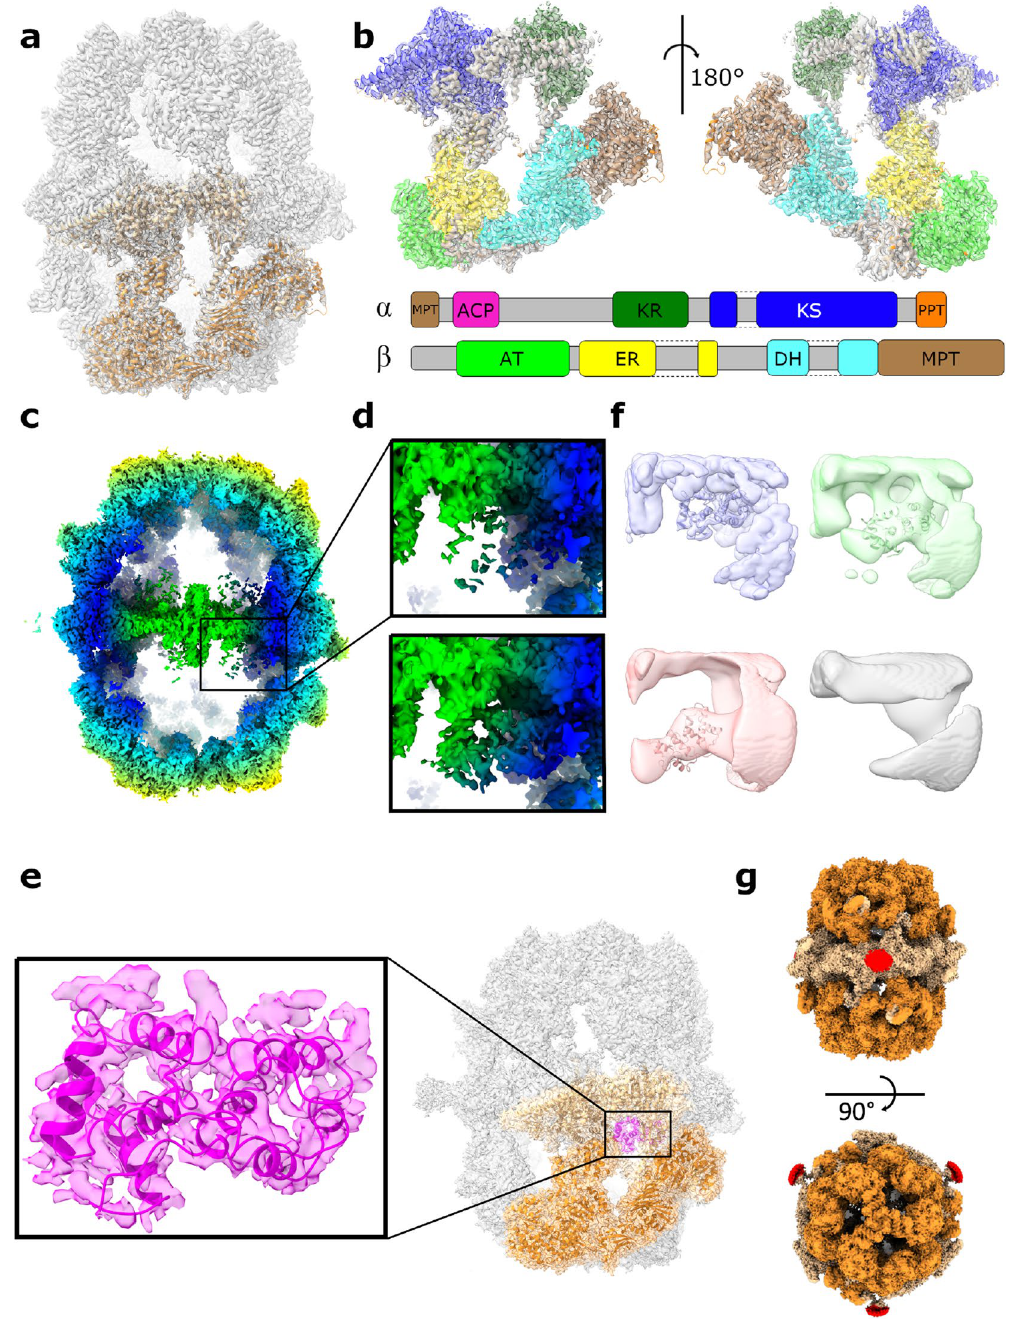
Figure 2. The molecular structure of P. pastoris FAS. ( a ) Atomic coordinates for the asymmetric unit of P. pastoris FAS, comprising α (light orange) and β (dark orange) subunits, with the density map overlaid. ( b ) Enlarged view of the asymmetric unit, highlighting different enzymatic domains according to the colour scheme indicated in the domain organisation schematic (below). Grey-coloured regions are non-enzymatic, structural domains. Domain boundaries were assigned based on equivalent domain boundaries from S. cerevisiae FAS. MPT—malonyl/palmitoyl transferase, ACP—acyl carrier protein, KR—ketoacyl reductase, KS—ketoacyl synthase, PPT—phosphopantetheine transferase, AT—acetyl transferase, ER—enoyl reductase, DH—dehydratase. ( c ) Clipped view of the sharpened FAS density map, coloured according to radius. The box highlights the region of the reaction chamber selected for the first focussed 3D classification. ( d ) Enlarged image of the region depicted by the box in ( c ) (upper) compared with the sharpened, asymmetric reconstruction of FAS derived from an ACP density-containing class from the first focussed 3D classification (lower). Further details (including all classes) from the first focussed classification are given in Supplementary Fig S2a-c. ( e ) Atomic coordinates for the ACP domain of FAS fitted into ACP density from the map shown in ( d , bottom). ACP is also shown in the context of the full FAS complex. ( f ) Representative classes from the second focussed 3D classification (with expanded masked region) of the complex interior. Atomic coordinates for ACP are shown fitted into the three classes containing putative ACP density to give an indication of size. One class shows no putative density for ACP (lower right). All maps are shown at the same contour level. All classes from the second focussed classification are given in Supplementary Fig S2d. ( g ) Density map of FAS shown at a low contour level (i.e., including weak density), coloured according to subunit (α—light orange, β—dark orange). Low-resolution density corresponding to the flexible dimerization module 2 (DM2) element is highlighted in